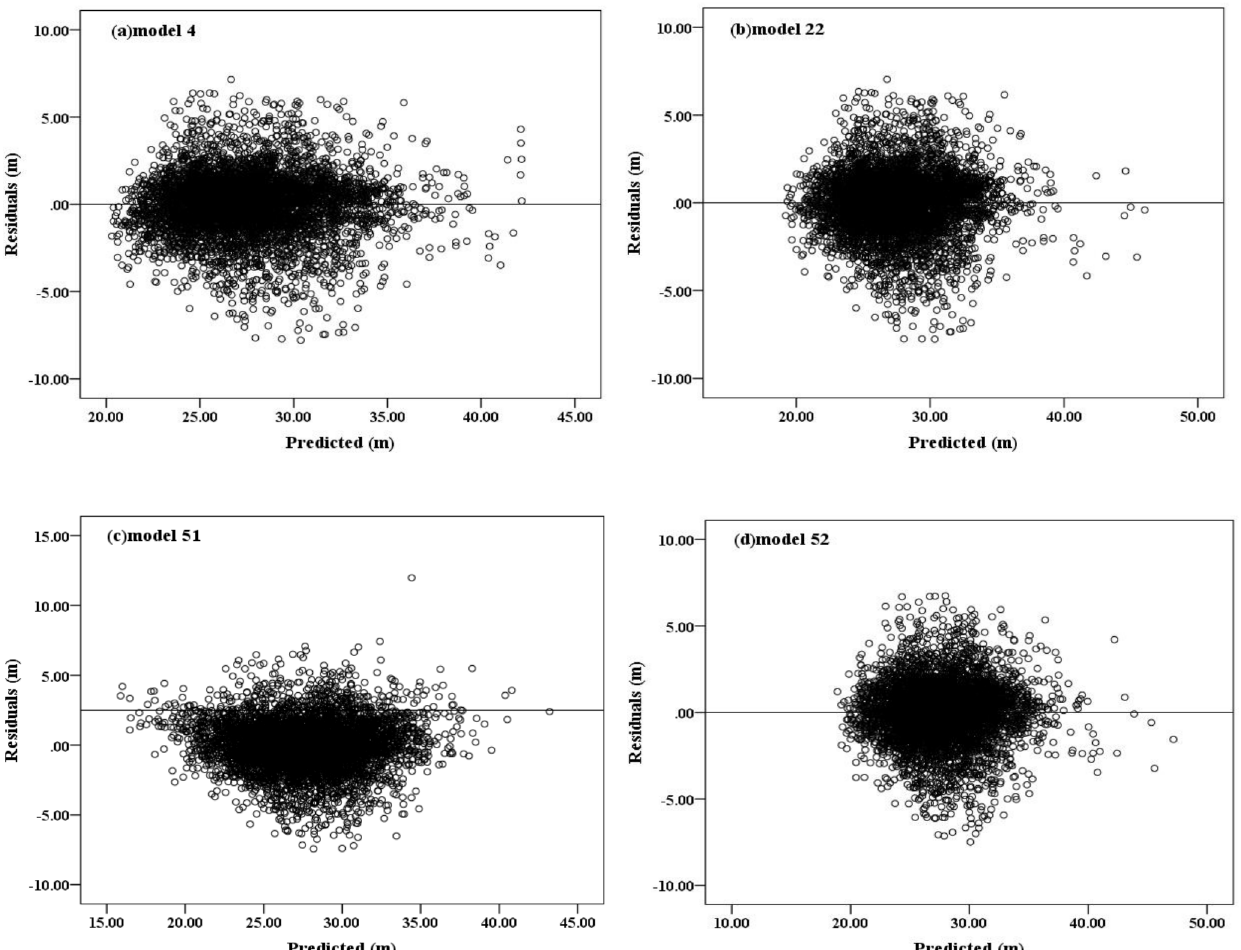
Fig 4. Residualplots in the calibrationdataset for the three best models (a: Model 4; b: Model 22; c: Model 51; d: Model 52). doi: 10.6084/m9. figshare.4956284.g004.